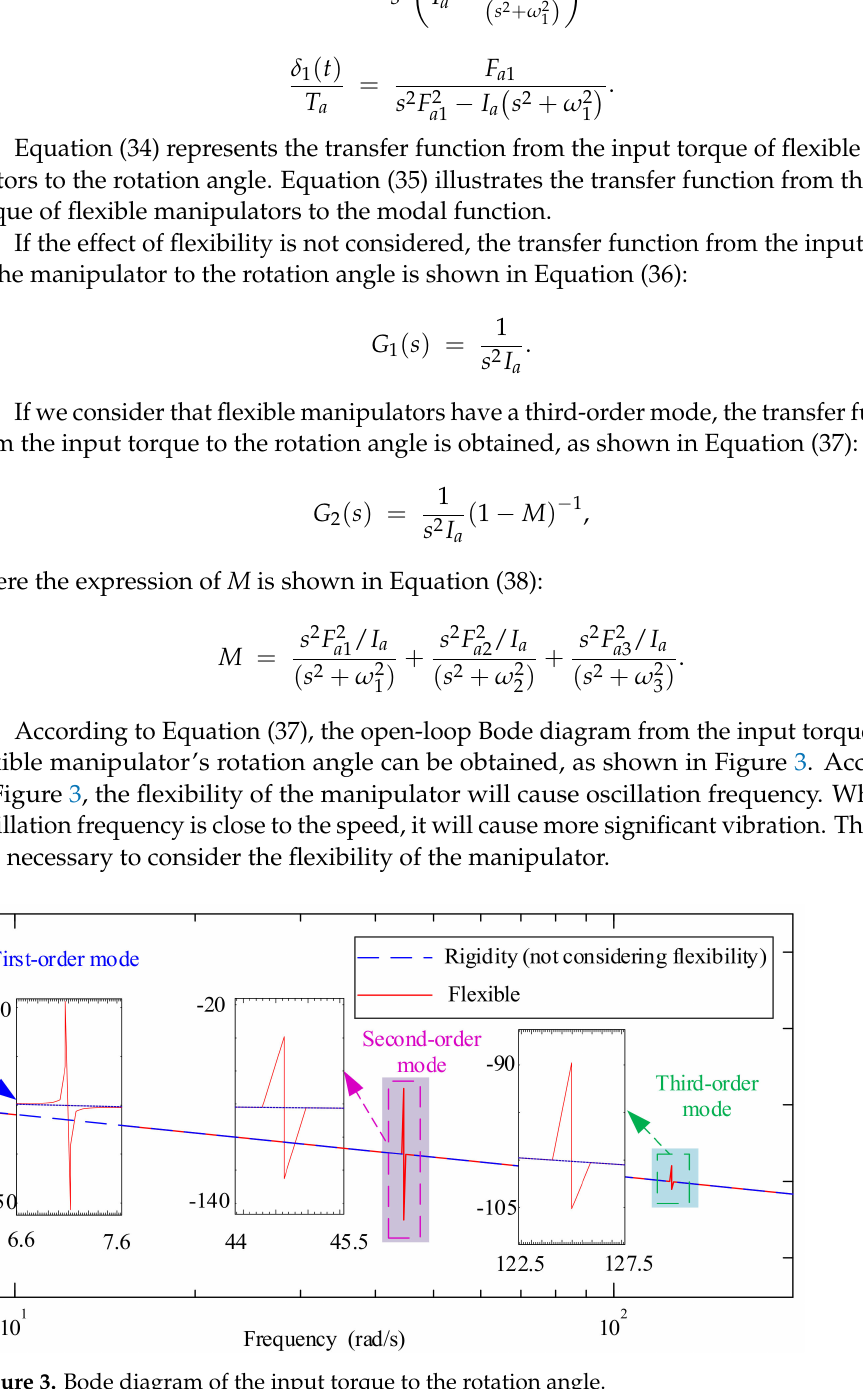
Figure 3. Bode diagram of the input torque to the rotation angle. The length and the elastic modulus of the flexible manipulator will impact the oscilla- tion frequency of the open-loop transfer function, as shown in Figure